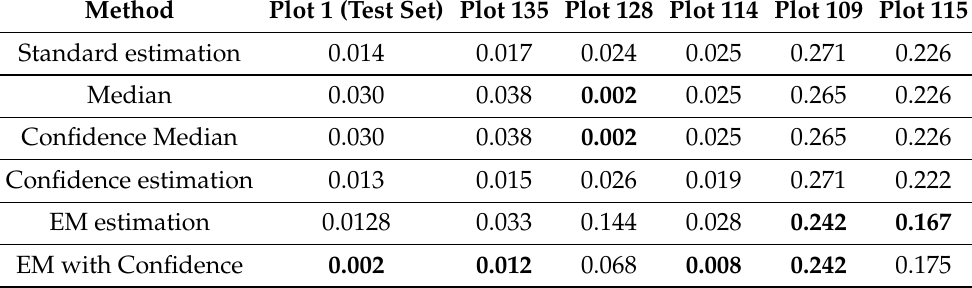
Table 6. Relative error in the task of Mean spikelet-per-spike count estimation. Results are shown for six fields, as obtained using standard averaging and suggested robust estimation methods. The best results for each field are highlighted in